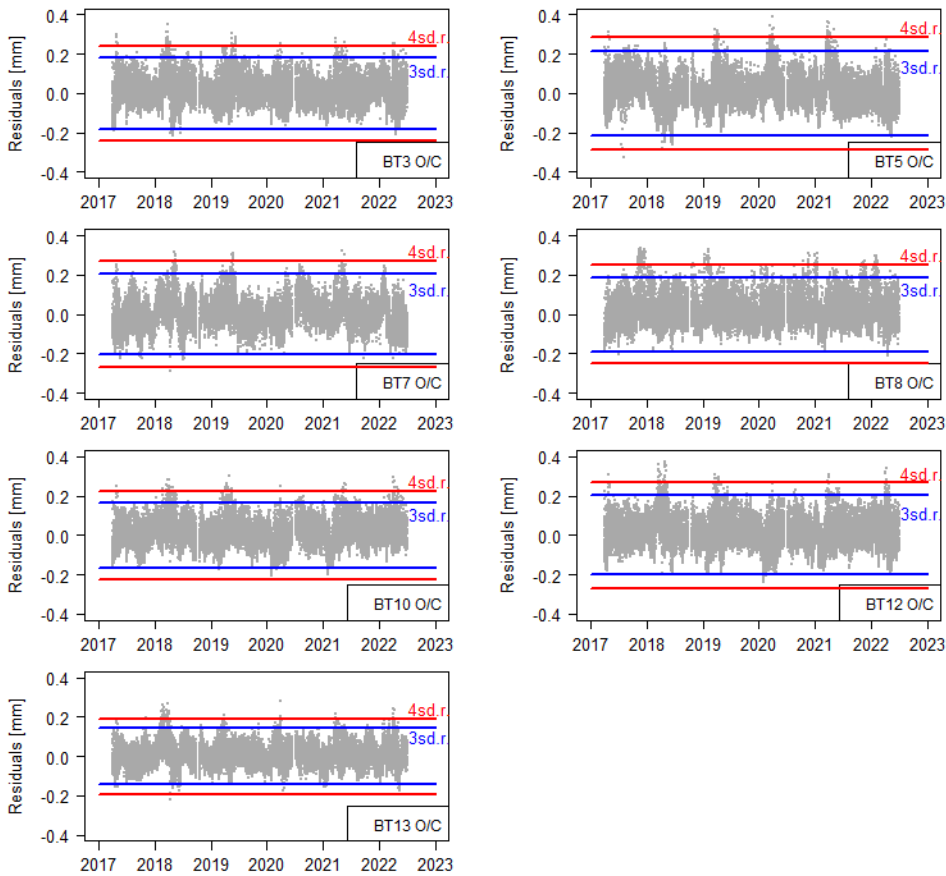
Figure 15. Residuals of the movements measured through 3D